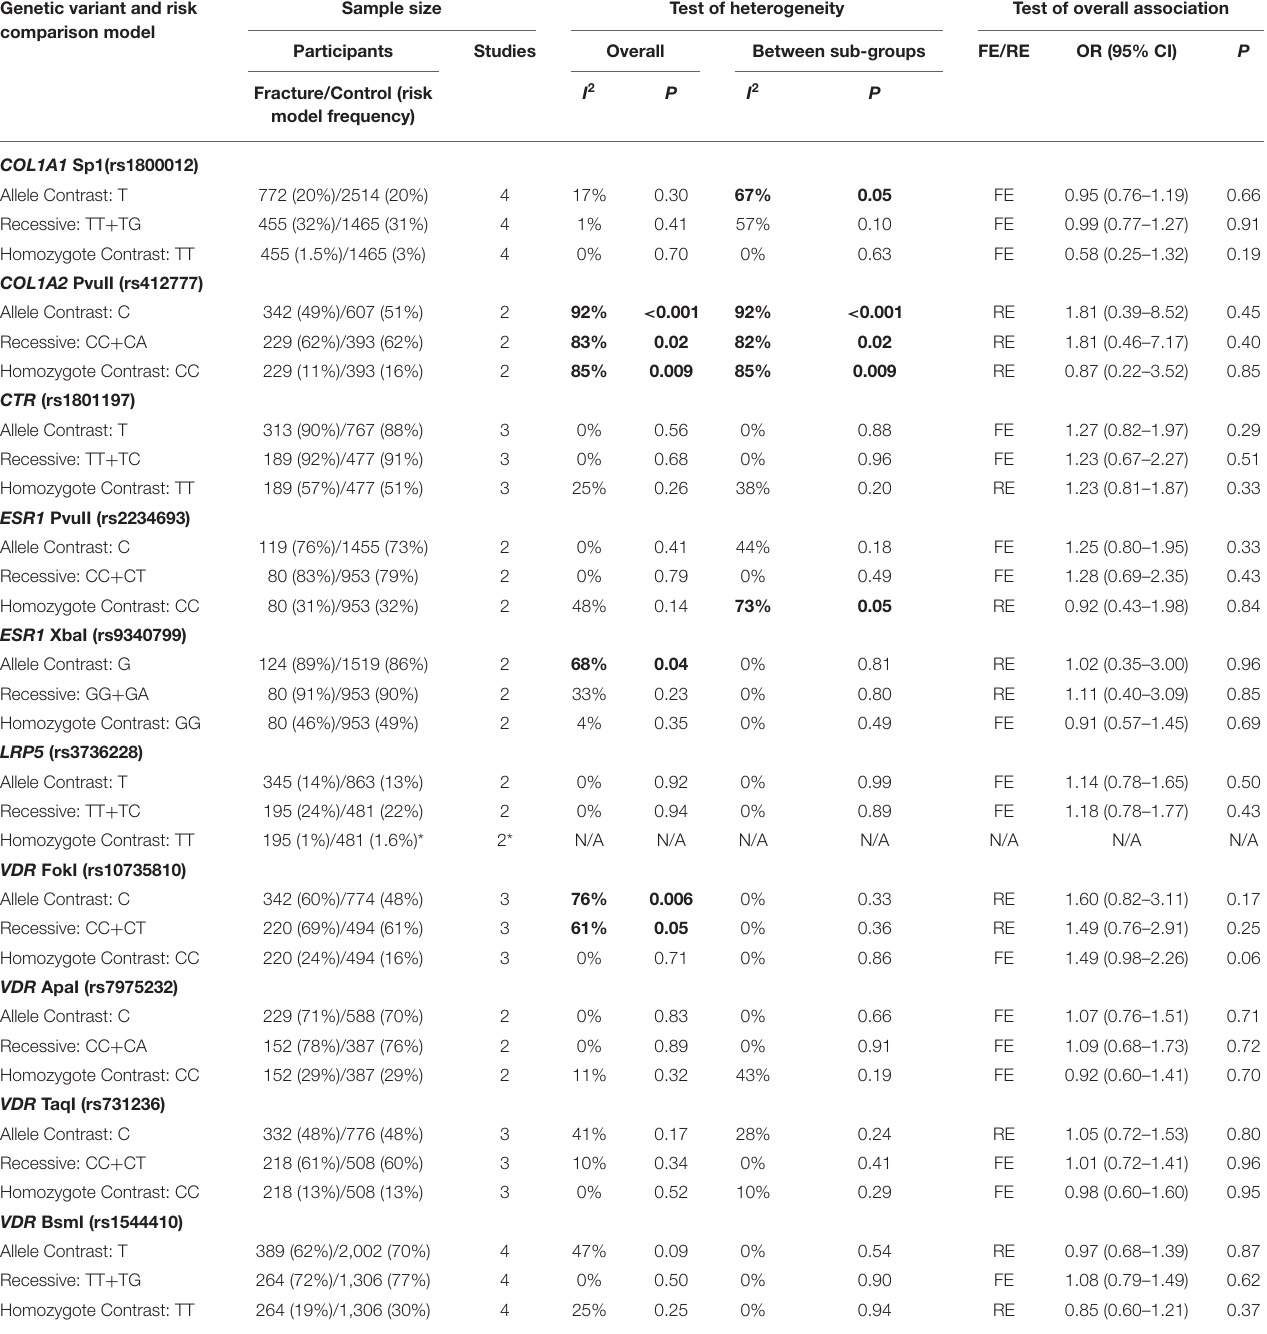
TABLE 3 | Summary effects from the overall analyses of case-control association studies for genetic variants associated with fracture occurrence risk in physically active participants including all studies and sex sub-groups. Genetic variant and risk Sample size Test of heterogeneity Test of overall association comparison model Participants Studies Overall Between